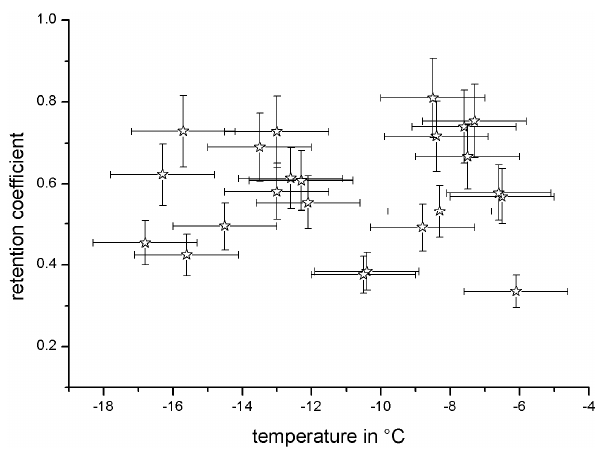
Fig. 6. Retention coefficient of H 2 O 2 as a function of air tempera- Figure 6. Retention coefficient of H 2 O 2 as a function of air temperature, determined with 2 ture, determined with quasi-floating snow flakes rimed with solution quasi-floating snow flakes rimed with solution droplets with a concentration of 1 ppmv. 3 droplets with a concentration of